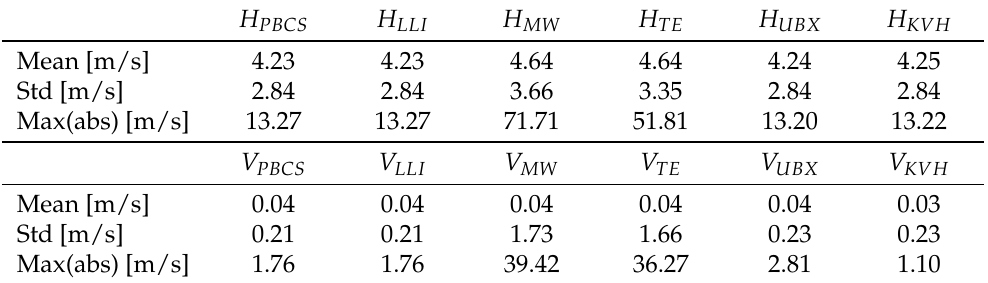
Table 8. Horizontal and vertical velocity statistics—Case Study 2.